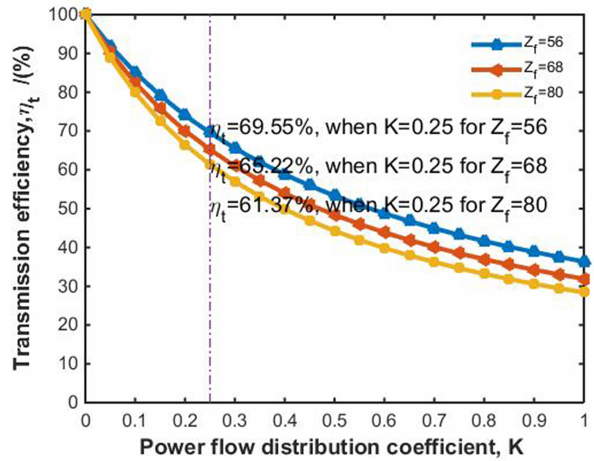
Figure 2. Influence of the transmission efficiency about Power flow distribution